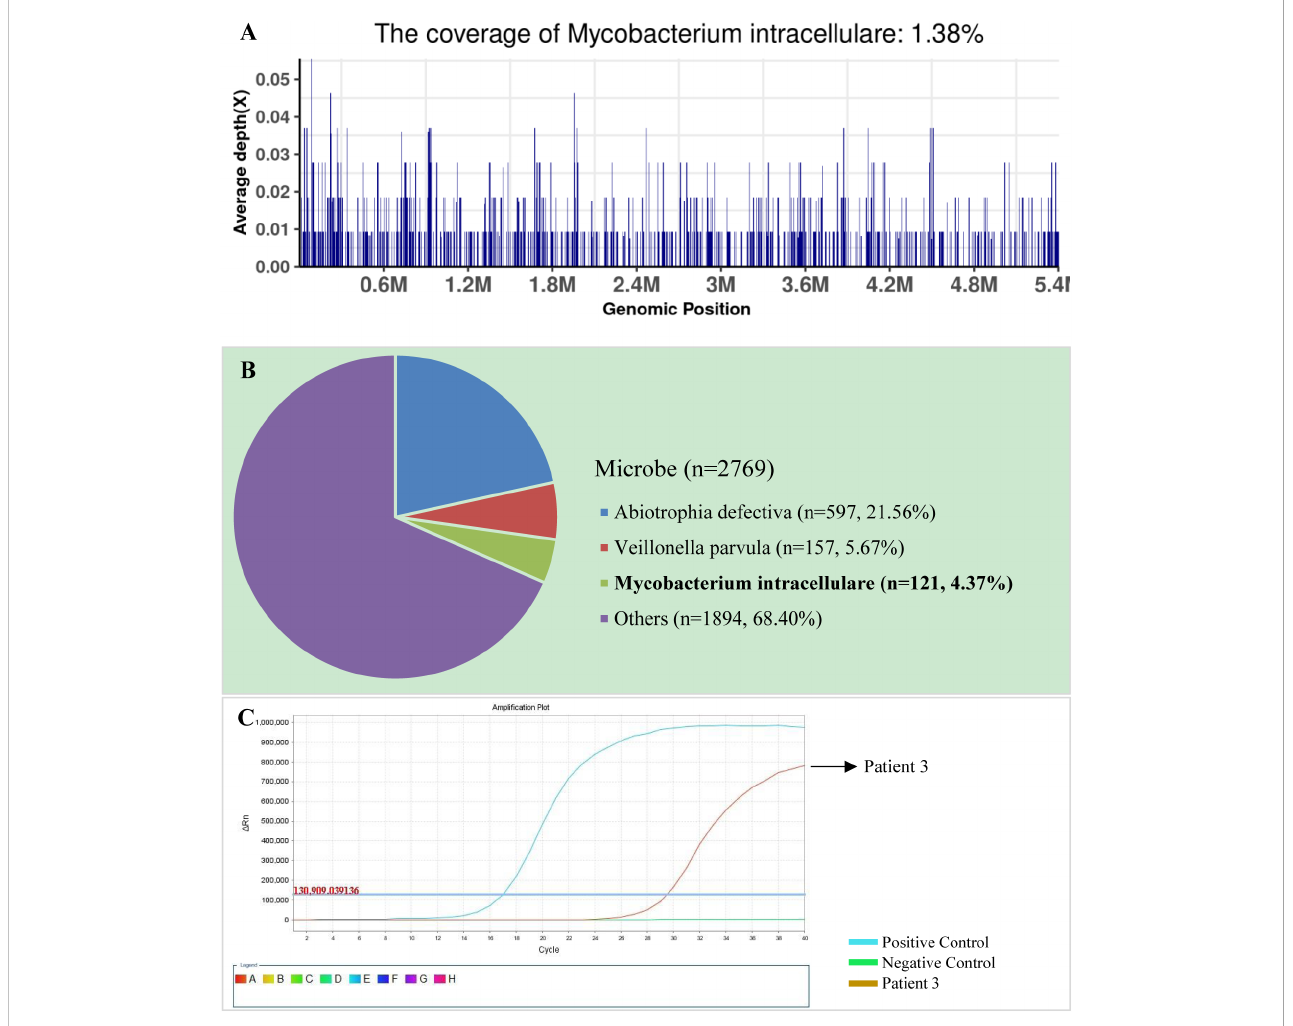
FIGURE 2 The bronchoalveolar lavage fl uid (BALF), metagenomic next-generation sequencing (mNGS), and quantitative polymerase chain reaction (PCR) results for patient 3. (A) The genome coverage of Mycobacterium intracellulare , with 812 reads mapped to the genome of M. intracellulare . (B) The species composition of the BALF microbes, with 121 species-speci fi c reads mapped to the genome of M. intracellulare . (C) Positive qPCR results for M. intracellulare